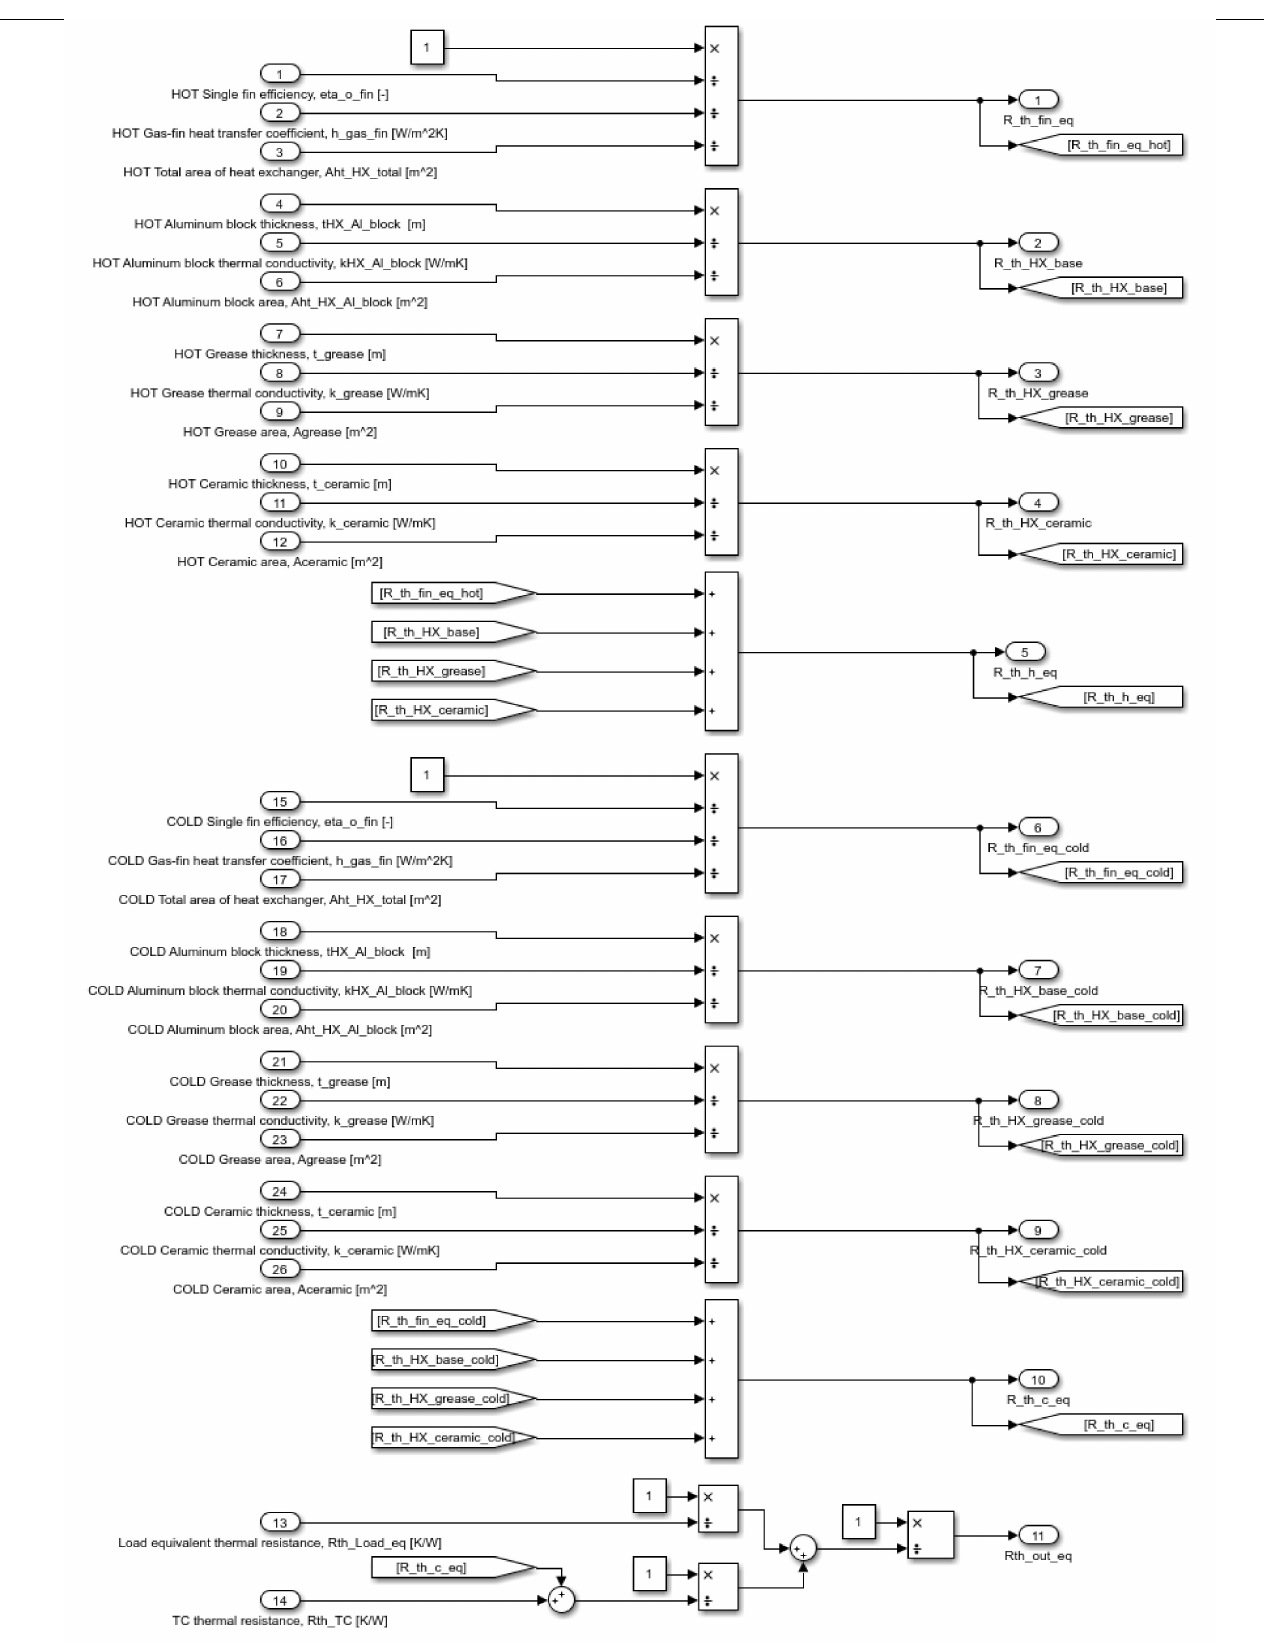
Figure A12. Thermal resistance network